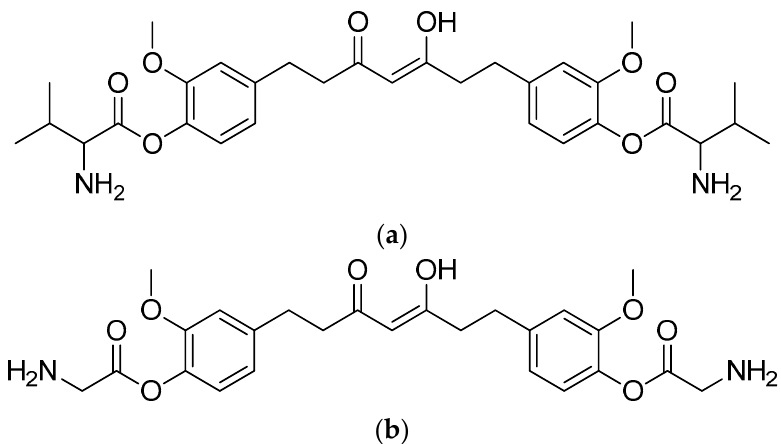
Figure 14. ( a ) Tetrahydrocurcumin–L-glycine; ( b ) tetrahydrocurcumin–L-valine.